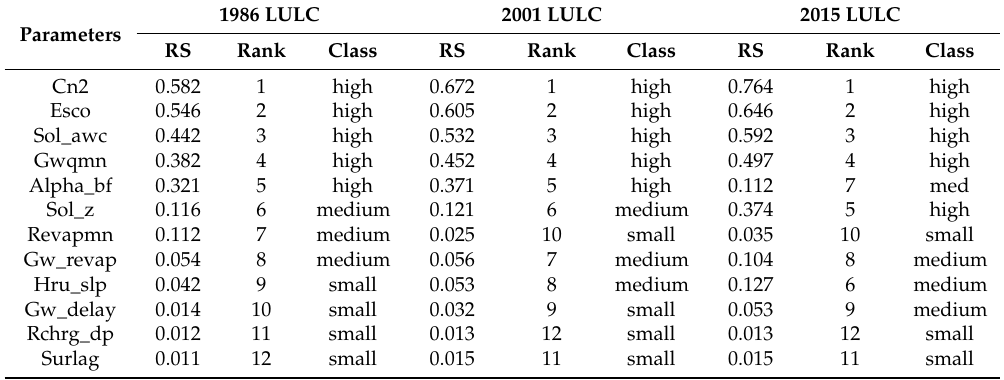
Table 2. Relative sensitivity of SWAT parameters for river flow under land use land cover changes.